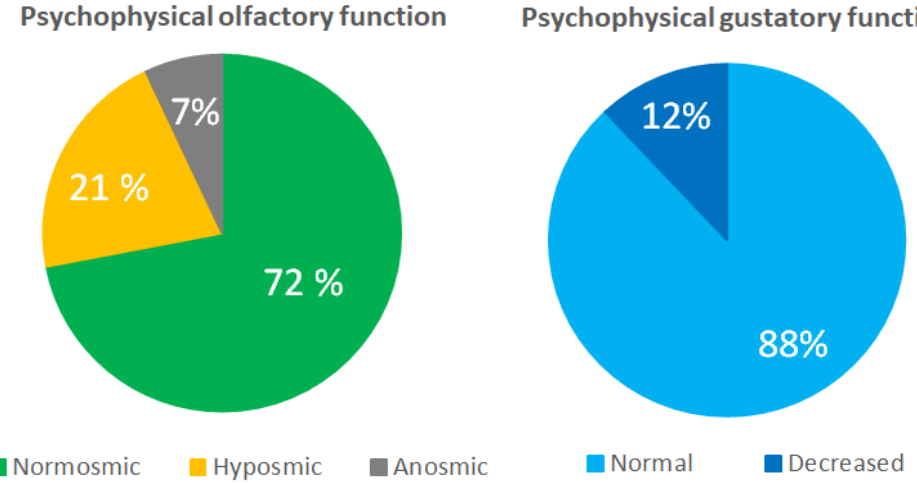
Figure 2. Psychophysical olfactory (Threshold, Discrimination, and Identification) and gustatory function (taste strips) 3–6 months after hospitalisation for COVID-19.